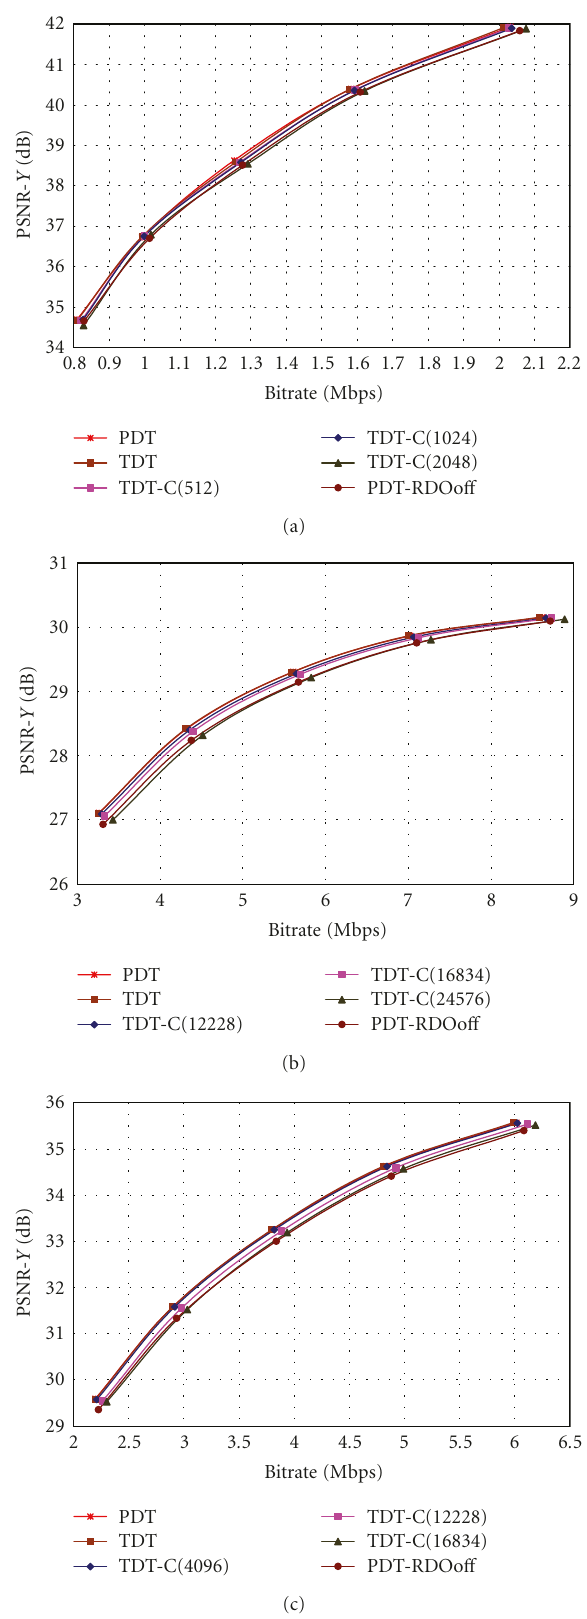
Figure 11: RD performance evaluation of TDT-C transcoder with di ff erent thresholds: (a) Akiyo; (b) Mobile; (c) Stefan.